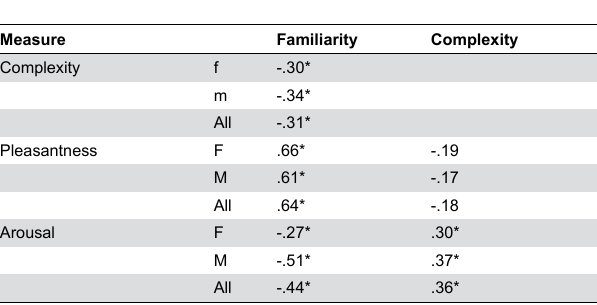
Table 1. Spearman’s rank-order correlations between ratings of familiarity, complexity, pleasantness and arousal of IAPS pictures (N